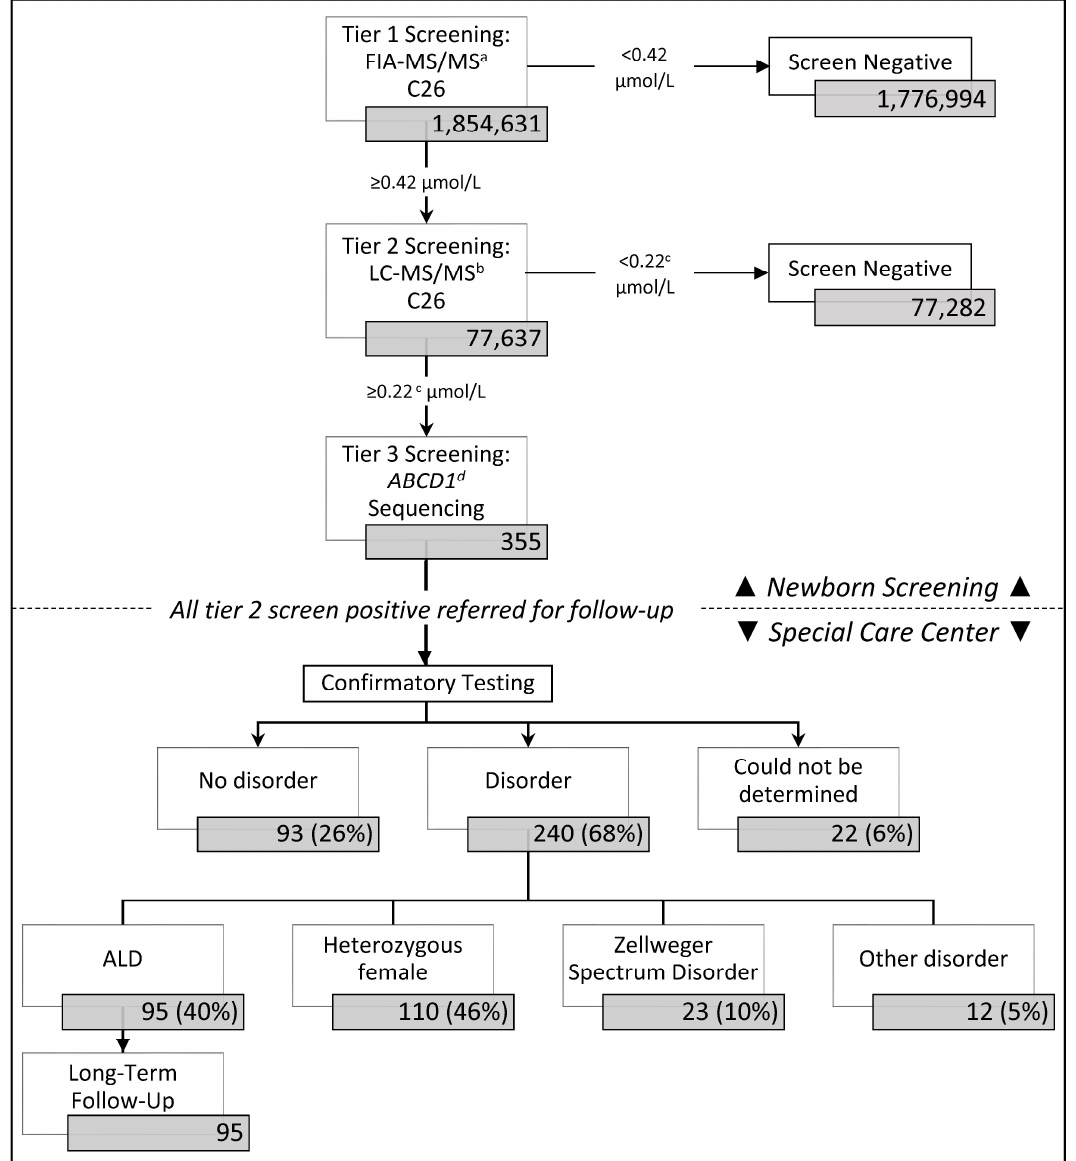
Figure 1. California adrenoleukodystrophy (ALD) newborn screening and follow-up algorithm. a FIA-MS/MS = flow injection analysis-tandem mass spectrometry. b LC-MS/M = liquid chromatography-tandem mass spectrometry. c The 2nd tier cutoff was originally set at ≥0.15 µmol/L, but was adjusted to ≥0.22 µmol/L in December 2017 to improve screening performance. d ABCD1 = ATP binding cassette subfamily D member 1 gene.